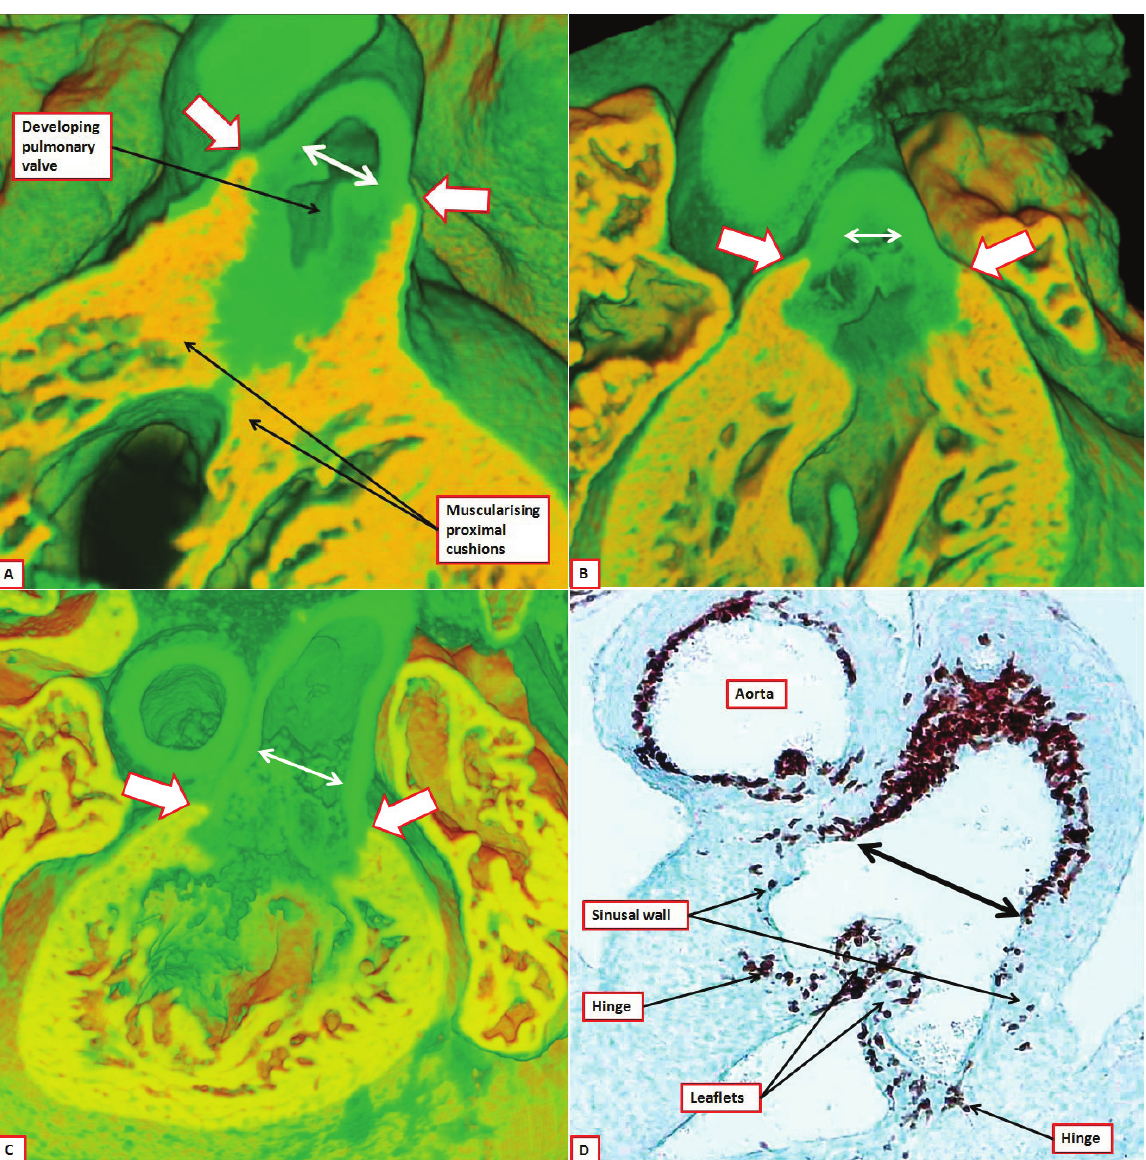
Figure 11. The images are from developing mice at E13.5 (panel ( A )), 14.5 (panel ( B )), and 15.5 (panels ( C ) and ( D )). The sections in panels ( A ) through ( C ) are from episcopic datasets prepared from mice in which the myocardium had been marked with a cre to myosin light chain. Panel ( D ) is a section from a Wnt1-cre mouse, with the brown stained tissues derived from the neural crest. The panels show how, over the period of development from E13.5 through E15.5, there is gradual excavation of the outflow cushions combined with regression of the distal myocardial border (white arrows with red borders) and ingrowth on non-myocardial tissues to form the valvar sinuses. The end-result is to elongate the distance from the hinge of the developing valvar leaflets to their distal attachment at the sinutubular junction (double headed white and black arrows). The semilunar hinges themselves join together at the distal sinutubular junction (see Figure